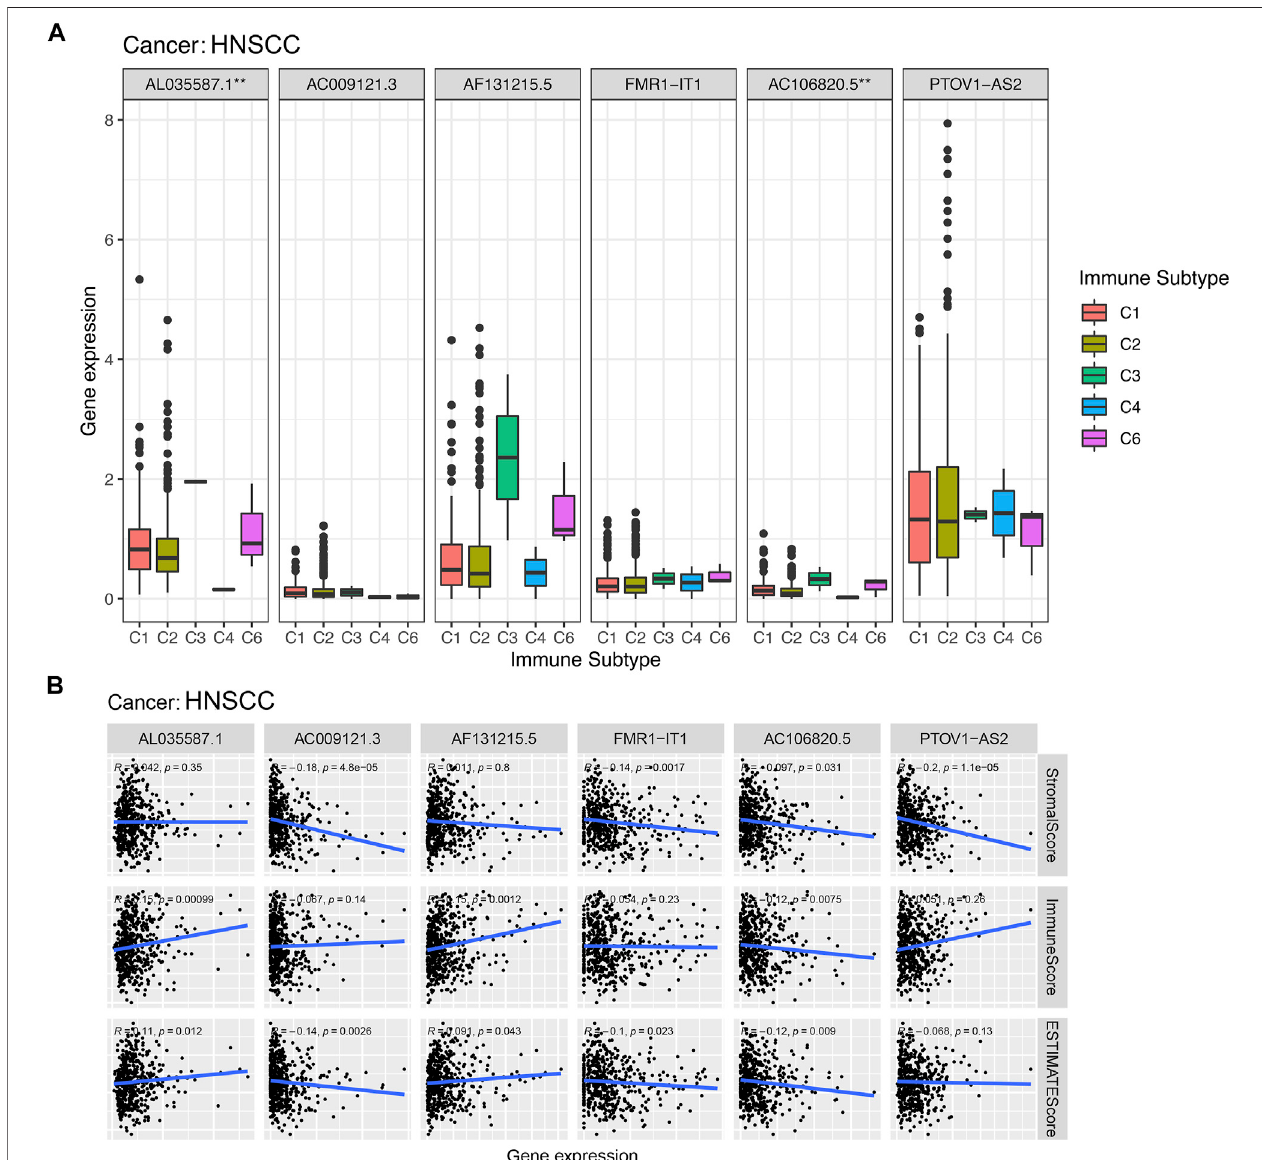
FIGURE9| Associationofexpression ofprognosticlncRNAs withwithimmune response,TME.*, **,***represent p < 0.05, p < 0.01and p < 0.0001, respectively. (A) Association of prognostic lncRNAs expression with immune subtypes in HNSCC patients. (B) Correlation of expression of prognostic lncRNAs with TME (Stromal score, Immune score, and ESTIMATE